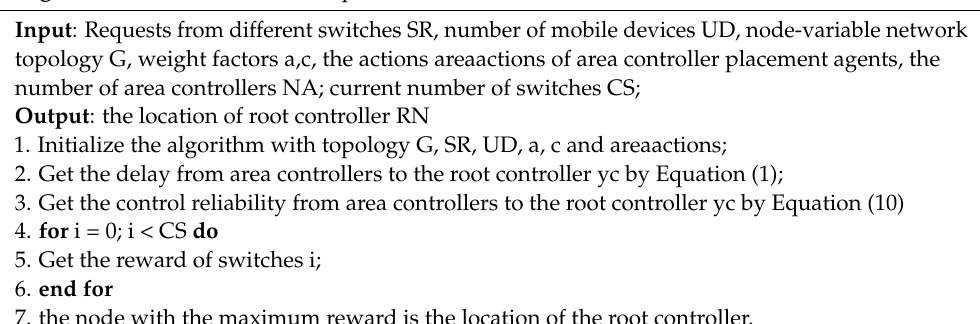
Algorithm 2. The root controller